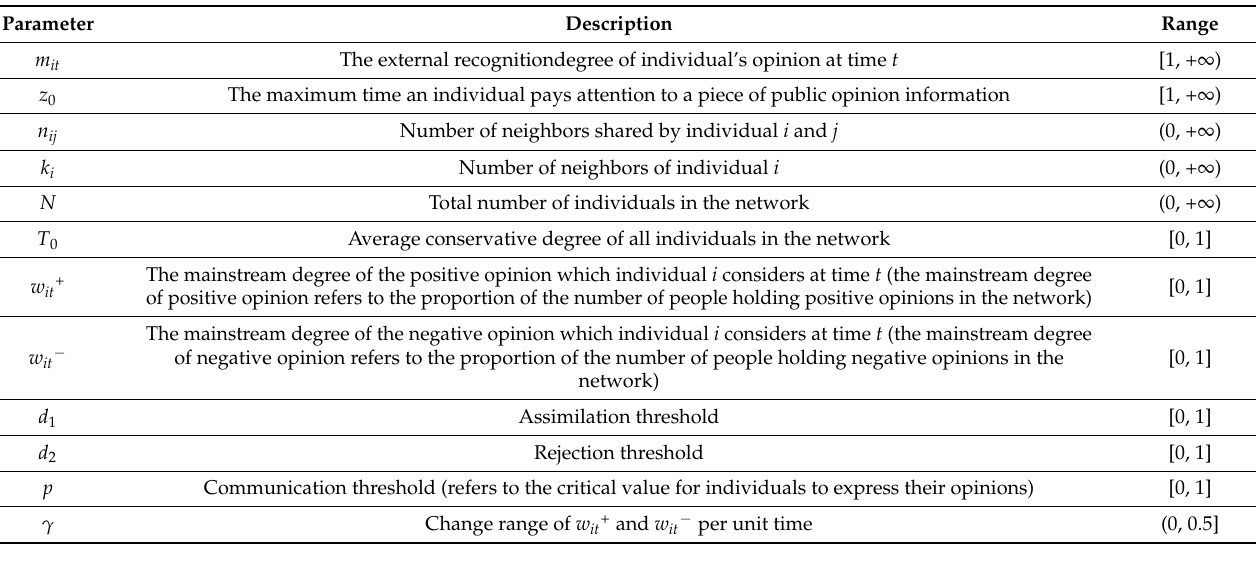
Table 1. Related parameters.